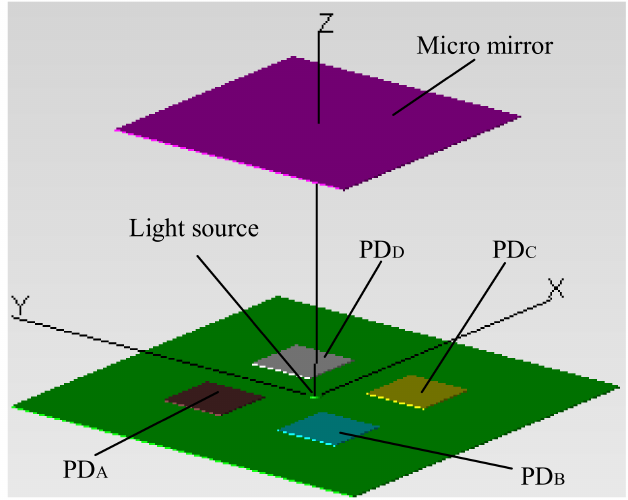
Figure 9. Model of the optical